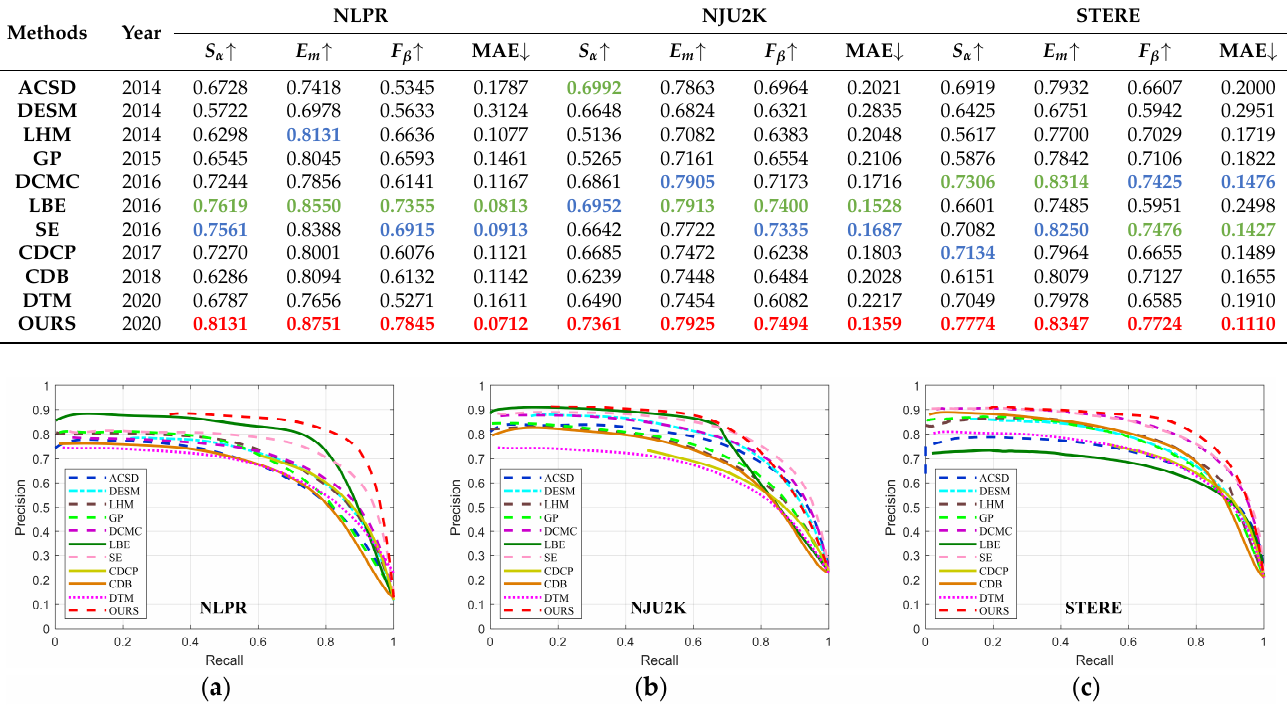
Table 1. Quantitative comparisons of different RGB-D saliency detection methods on three popular datasets. Red , green and blue indicate the best, second and third performances. ↑ denotes larger is better, and ↓ denotes smaller is better. Methods